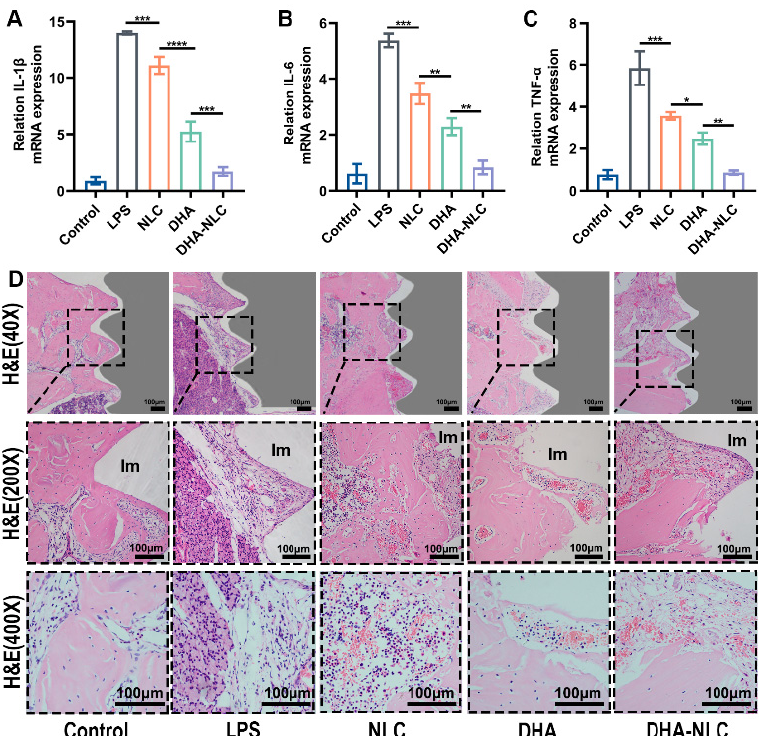
Figure 4. Anti-inflammatory effects of each group in peri-implantitis in vivo. ( A – C ) Effects of each group on the mRNA expression of IL-1 β , IL-6 , and TNF- α in peri-implant tissue. The results are presented as the mean ± SD (n = 3). ( D ) Representative H&E staining images of peri-implant tissues from each group (grey parts represent the implants). The dashed line box in the HE (40 × ) image is the selected viewing area, and the HE (200 × ) and HE (400 × ) are enlargements of this section. * p < 0.05, ** p < 0.01, *** p < 0.001, **** p < 0.0001. Scale bars: 100 µ m. LPS, lipopolysaccharide. NLC,